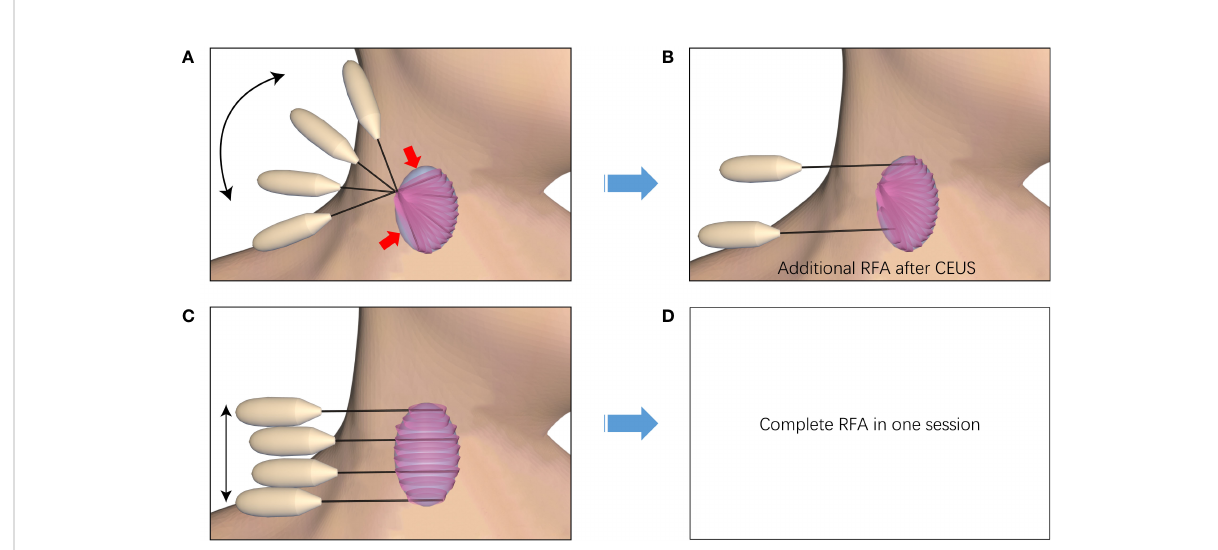
FIGURE 3 Diagram of needle placement strategies. The ablation planes are superimposed to achieve complete ablation of the entire nodule using one insertion point with a fan-shaped overlapping mode (A) or using multiple insertion points with a parallel overlapping mode (C) . The procedure using one insertion point with a fan-shaped overlapping mode may remain residual un-ablated areas which need to perform supplementary ablation (B) . The procedure using multiple insertion points with a novel parallel overlapping mode may achieve complete ablation (D)